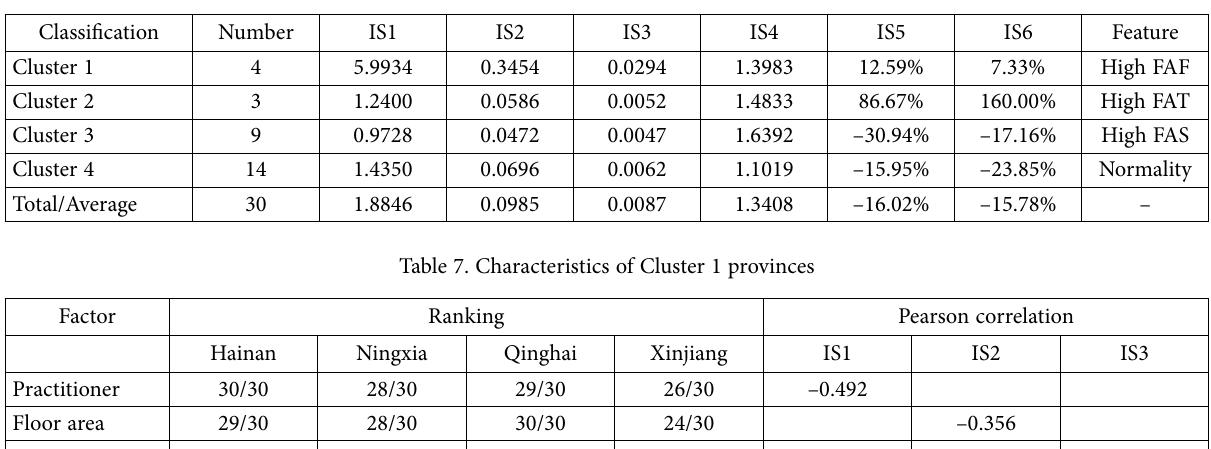
Table 6. Distribution of average values of indicators in each cluster